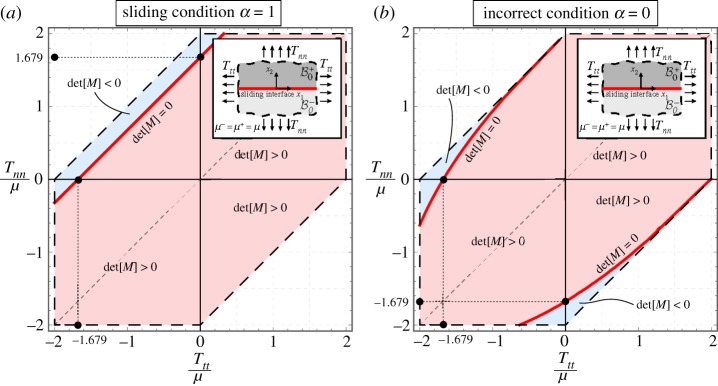
Interfacial bifurcation of two elastic incompressible half-spaces (made up of the same neo-Hookean material, subject to the same prestress) in contact through a planar sliding interface in the Tnn−Ttt plane for a sliding interface α=1. The incorrect condition α=0 is also includedfor comparison. The points corresponding to bifurcation are represented by red lines (at the boundary between the red and blue zones), while the dashed lines correspond to failure of ellipticity. Note that with α=1 bifurcation in pure tension occurs (i.e. with Ttt=0), which is excluded for α=0. Therefore, the (correct) sliding interface condition explains tensile bifurcation. Note also that in this case bifurcations for both negative stresses Tnn and Ttt do not occur (except in the domain of slightly negative Tnn). (Online version in colour.)